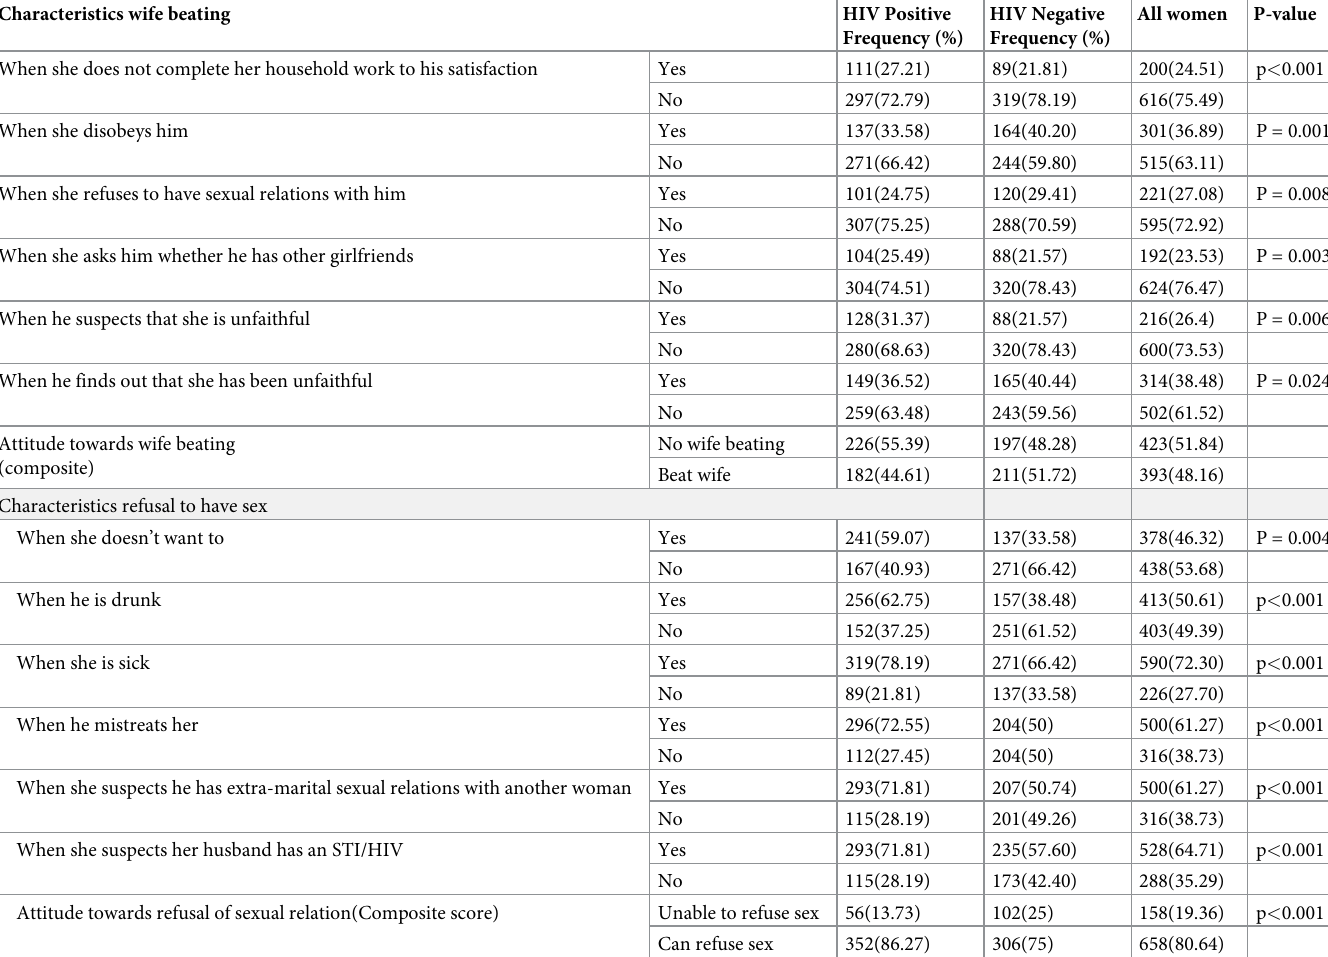
Table 4. Women’s attitudes towards partner beating in Wolaita Zone, Ethiopia, November-December